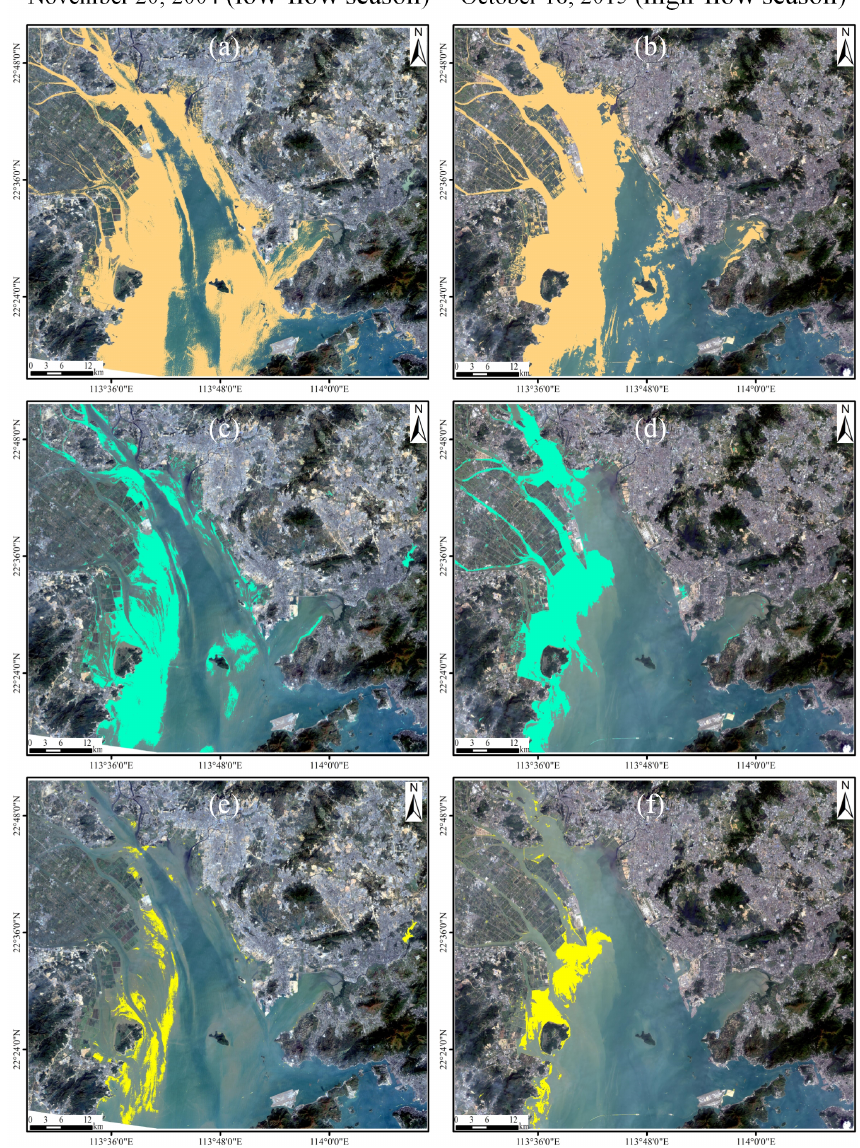
Figure 11. The true color imagery (USGS, 1982; NASA, 2001) and TMZ extraction results in the PRE at different times ( a, c, e : 20 November 2004; b, d, f : 18 October 2015) based on the TMZI method of this study (a and b , regions indicated by mango coloring, as in Figs. 7b and 8d), the criterion by Shi et al. (2017) ( c, d , regions indicated by cyan color), and the criterion by Wai et al. (2004) ( e, f , regions indicated by yellow